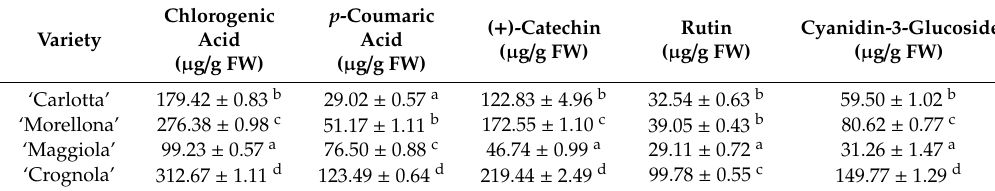
Table 3. The table reports the HPLC quantifications of specific bioactive molecules in the sweet cherry varieties sampled in 2018 expressed as µ g per gram of fresh weight (FW). The values are indicated with the relative standard deviation (number of independent biological replicates = 3); di ff erent letters indicate statistically significant di ff erences ( p < 0.05) among groups at the one-way ANOVA with Tukey’s post-hoc